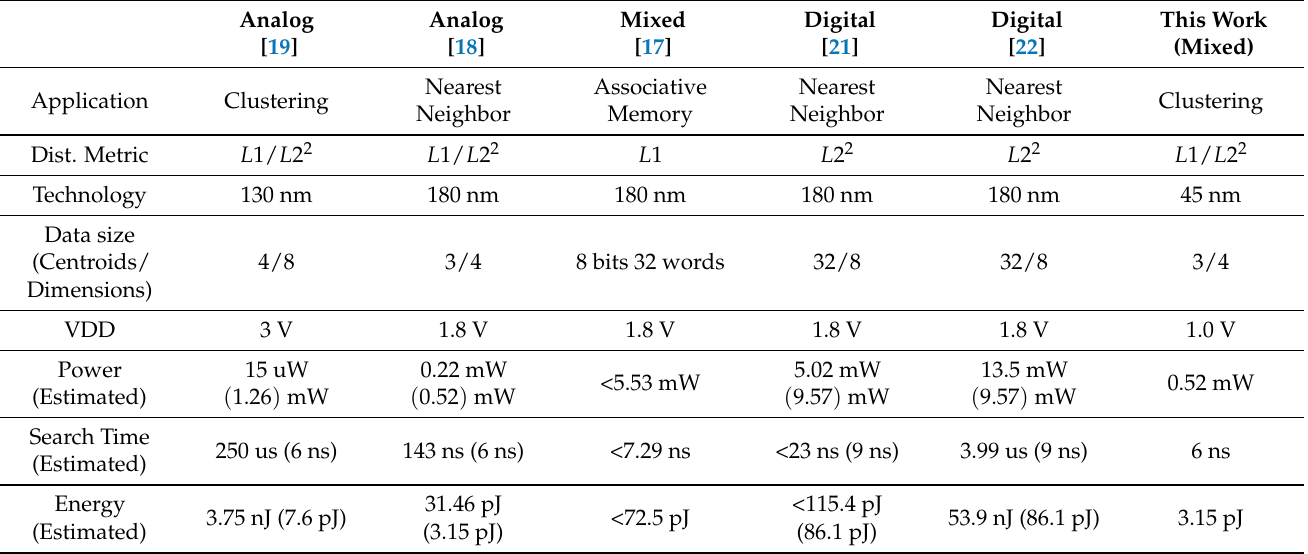
Table 1. Performance